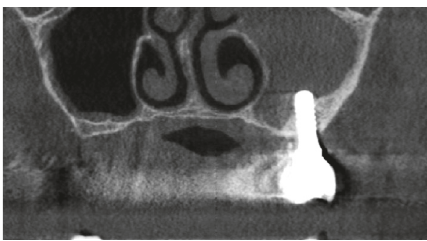
Figure 4: Six months after the removal of the implant 25. The cone- beam computed tomography image revealed that the opacity of the left sinus was still